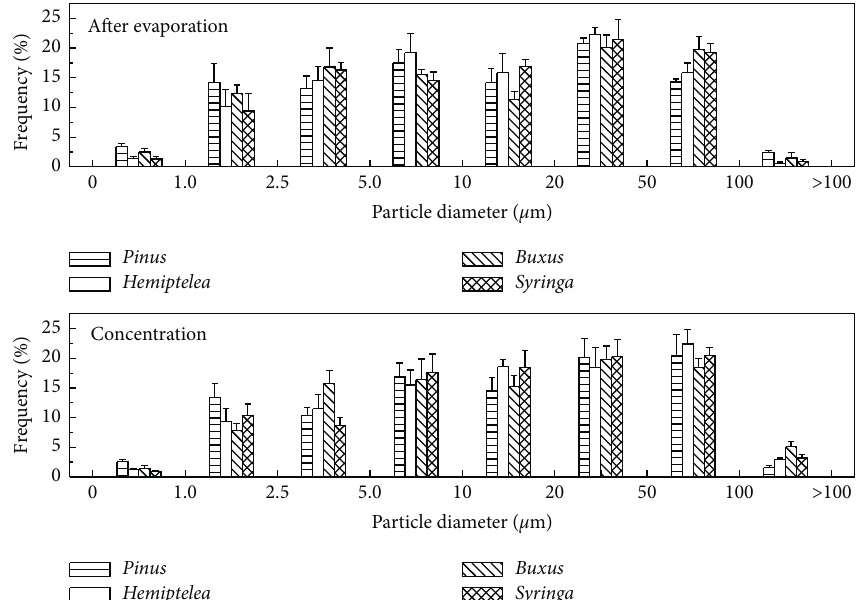
Figure 3: Particle size distribution during dew condensation and after dew evaporation among different plant species.